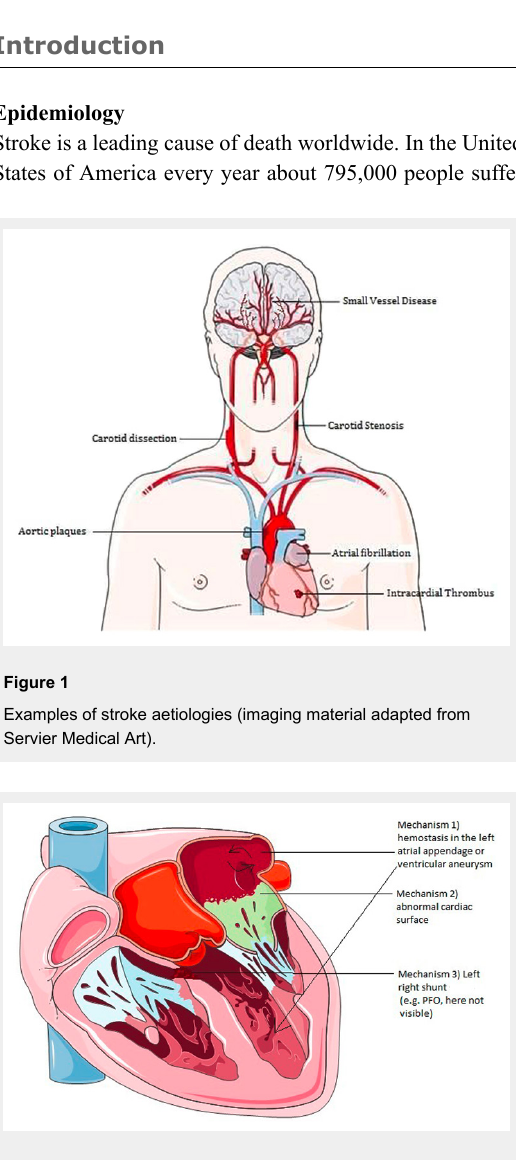
Most important mechanisms for the formation of cardiac embolism (imaging material adapted from Servier Medical Art). PFO = patent foramen